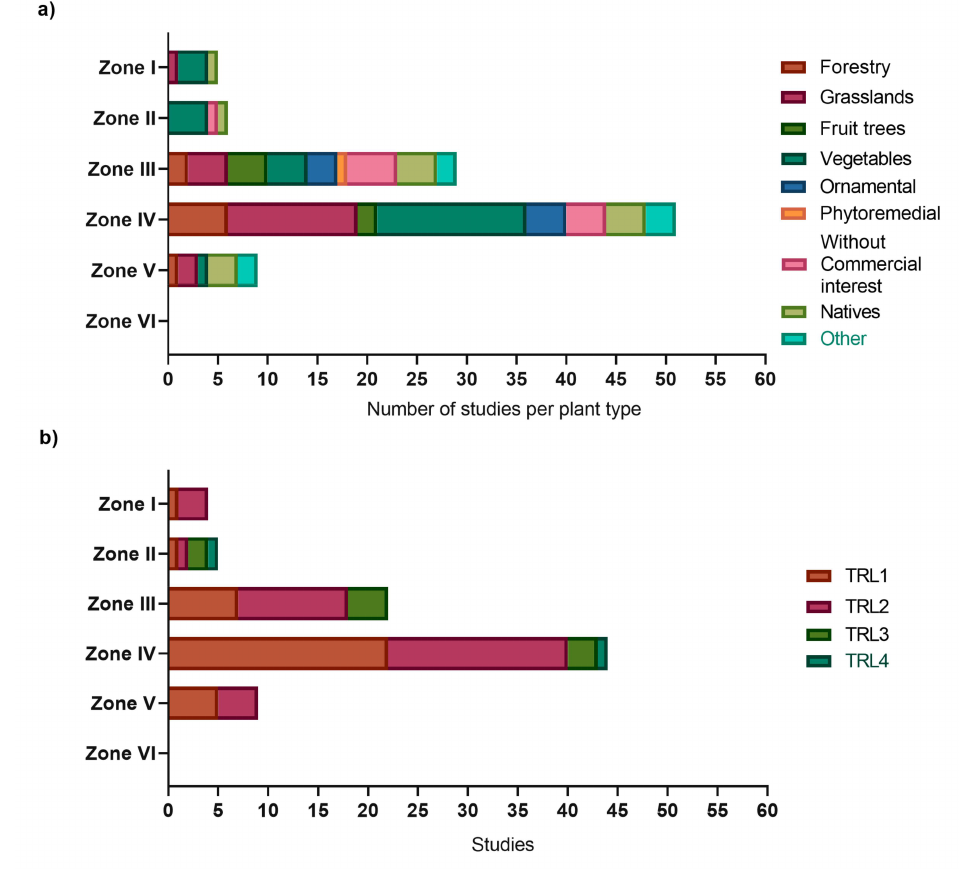
Figure 4. Biotechnological perspective of PGPM studies (only considering culture-dependent studies with microbial inoculation). ( a ) plant types used in PGPM studies (studies can account for more than one plant type), and ( b ) technology readiness levels obtained in the study. (For the description of zone I to zone VI, please refer to methodological Section